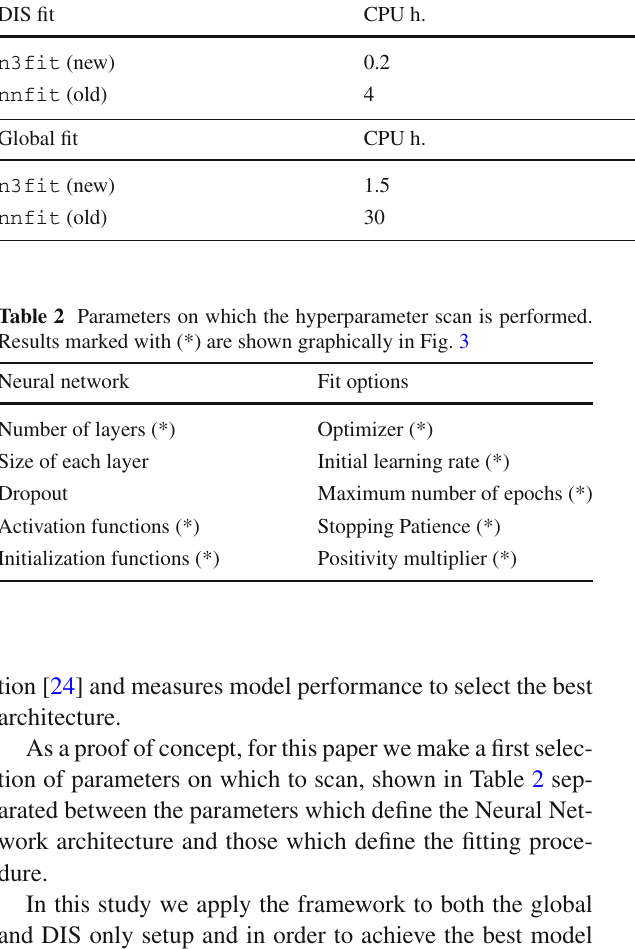
ger memory consumption in the global fit. Each fit can be comprised of 100–200 replicas.Good replicasarethosewhichpassallpost-fit criteria